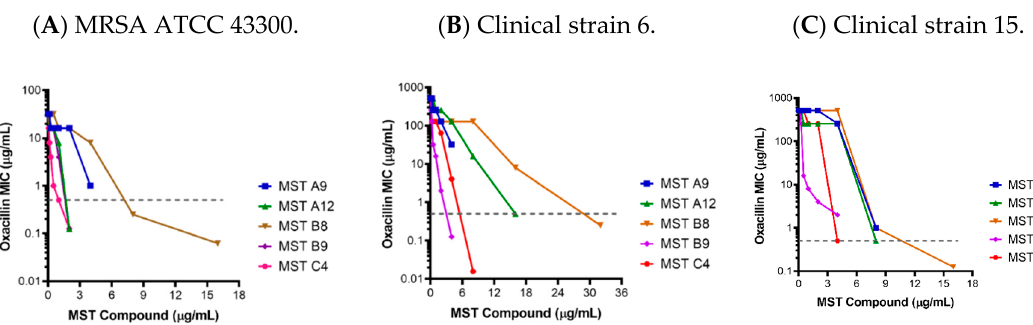
Figure 2. The MST compounds synergize with oxacillin to restore sensitivity in methicillin resistant Staphylococcus aureus . The MIC of MRSA ATCC 43300 and 16 clinical MRSA strains were determined in the presence of varying concentrations of the MST compounds. Results for the MRSA ATCC strain ( A ) and two representative clinical isolates ( B , C ) are shown with the graphs of all other clinical MRSA strains provided in Supplementary Figure S1. The MIC of MSSA ATCC 25923 for oxacillin (0.5 µg/mL) is indicated as a dotted grey line.